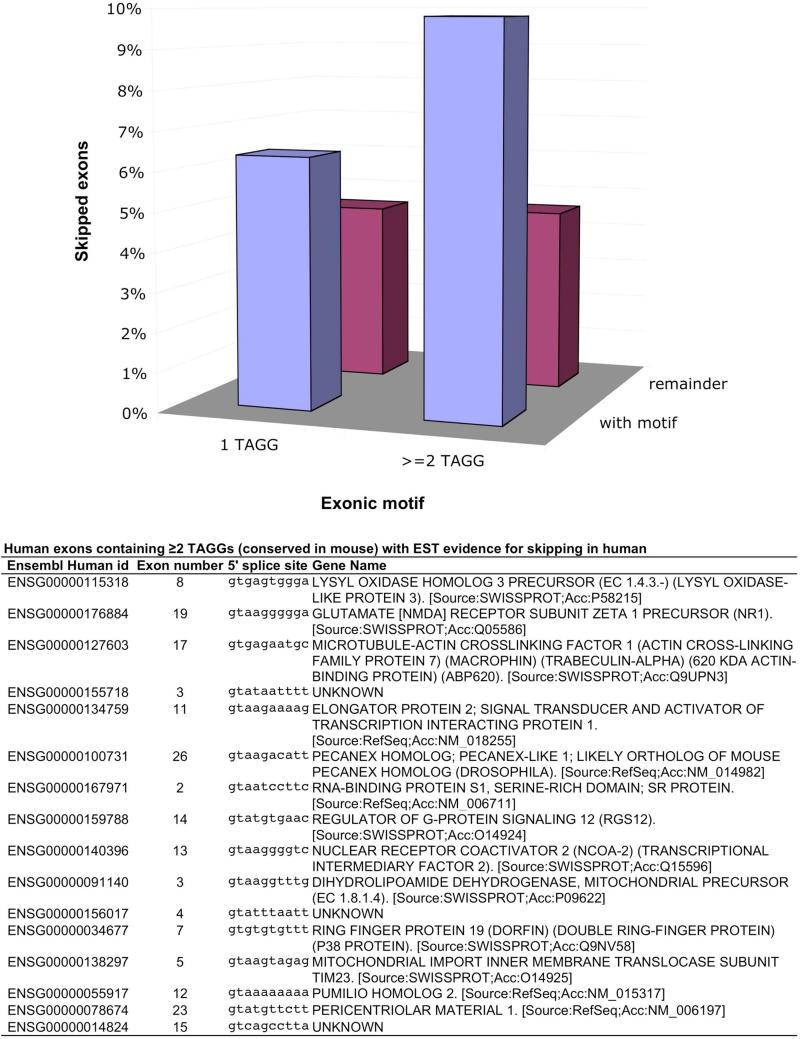
Computational Analysis of Exonic UAGG Motifs and Exon Skipping Patterns Genome-WideComputational searches were performed to identify exons with two or more UAGGs and to determine the association of confirmed exon skipping events with this group. Exons with a single UAGG were analyzed for comparison. The following constraints were applied: (1) exon lengths of 250 bases or fewer and (2) both UAGG motifs conserved in sequence and position in the orthologous mouse exons. The graph illustrates the percentage of confirmed exon skipping events associated with one UAGG or two or more UAGGs (blue bars), or with the remaining exons lacking these motifs (red bars). The list of 16 human exons identified with two or more UAGGs is shown with the Ensembl ID, exon number, 5′ splice site sequence, and gene name. It is not unexpected to find exon 19 of the glutamate NMDA receptor GRIN1 and exon 13 of NCOA2, which have a 5′-splice-site-proximal
GGGG, since the sequence of the 5′ splice site was not specified in the search.